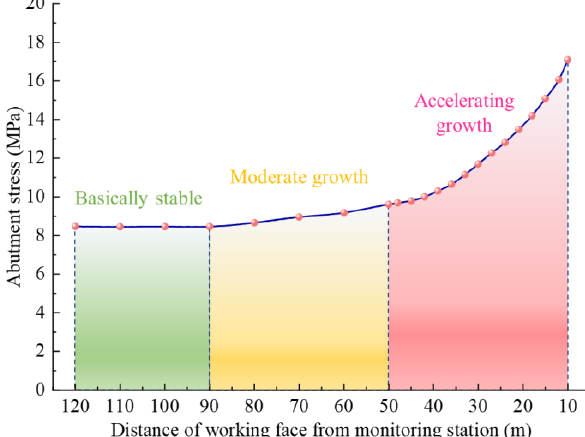
Figure 19. Monitoring results of the deep hole stress meters.